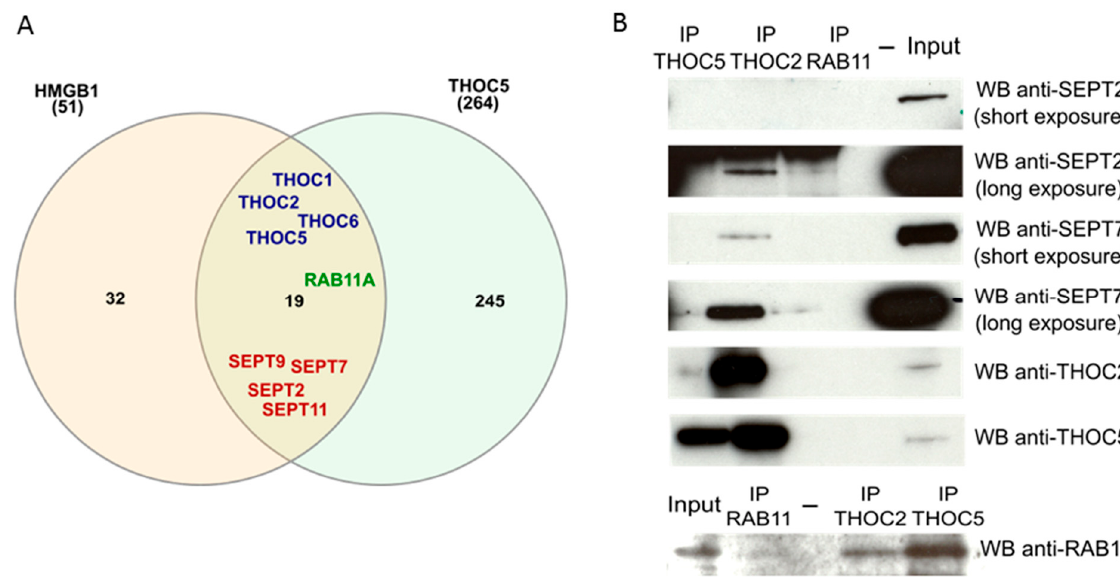
Figure 4. Interaction between septins and components of the THOC complex. ( A ) Common interactions detected in HMGB1 and THOC5 immunoprecipitates. ( B ) THOC2, THOC5 and RAB11 immunoprecipitates were probed with antibodies against SEPT2 and SEPT7.